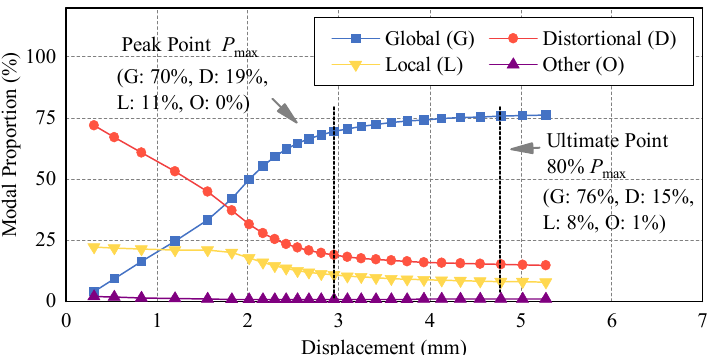
Figure 8. Full range modal participation of member FE simulation (member cross-section parameter is No.1, 2 mm thick, 900 mm long).